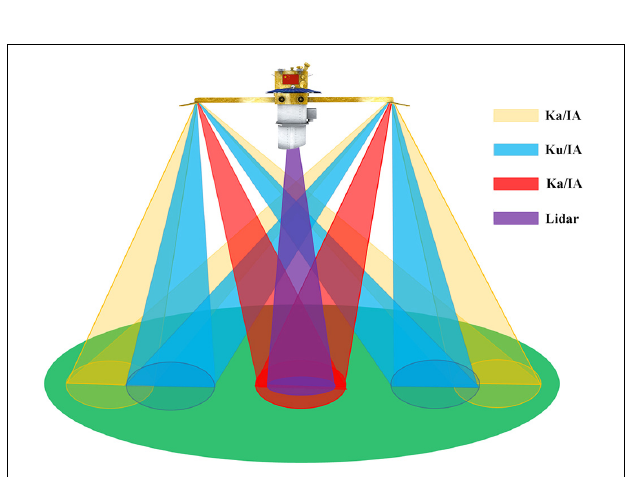
FIGURE 5 | Measurement scheme of the Guanlan IA/OL